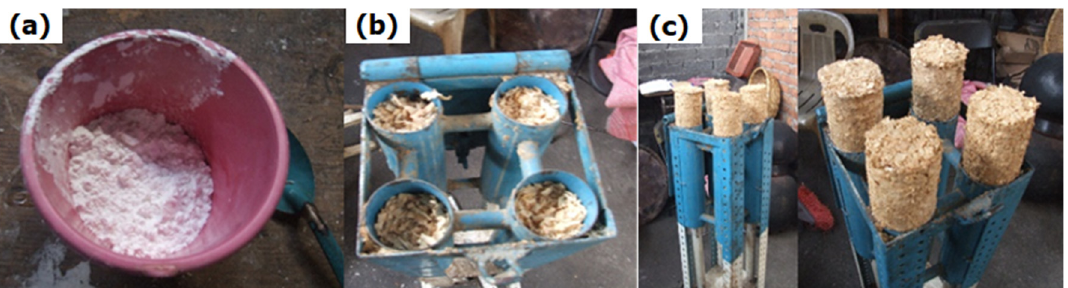
Figure 7. ( a ) Mixing all the materials; ( b ) emptying the mixture into the molds of the briquette-making apparatus; and ( c ) removing and drying the briquettes.